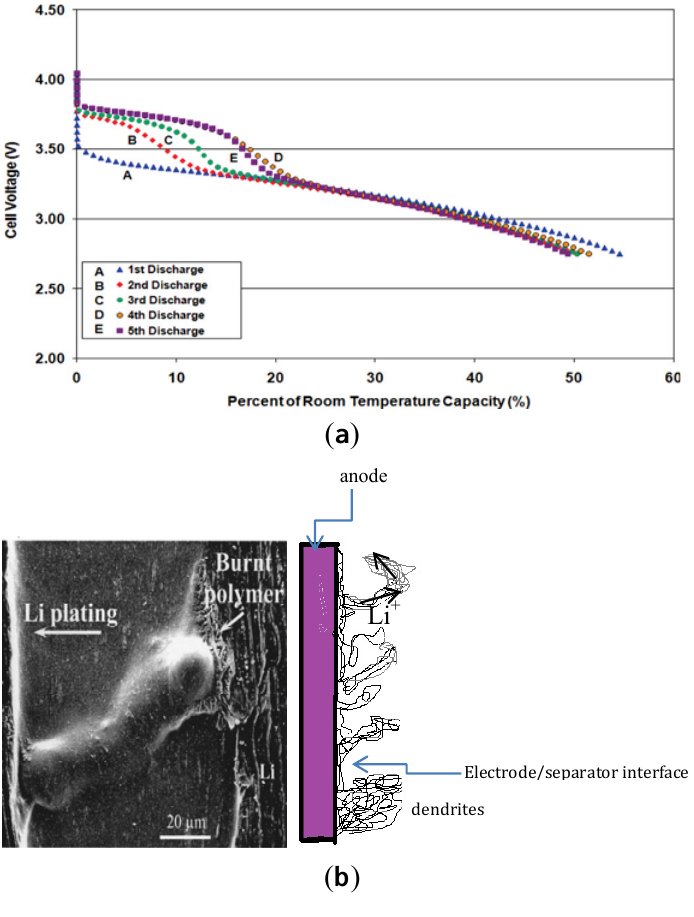
Figure 7. ( a ) Schematic current voltage over-potential caused by lithium plating [81]; ( b ) Lithium metal morphologies